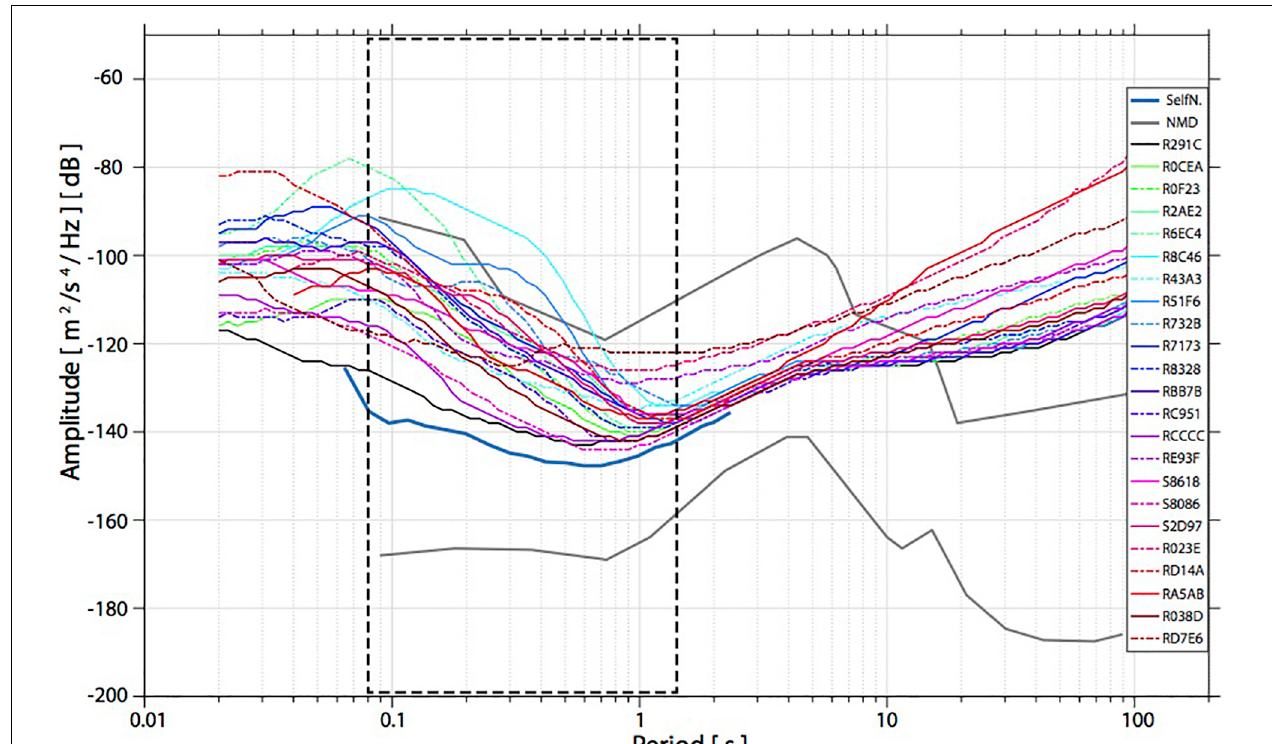
FIGURE 7 | Power spectral density probability density function’s median value for each NSSN station as a function of period. Thick gray lines are the high and low noise models (according to Peterson, 1993; McNamara and Buland, 2004). For comparison, we also plot the same curve from the test site in Switzerland (R291C), and the instrument self-noise as provided by the manufacturer. The dashed black line highlights the bandwidth of flat instrument response. The curves are constructed using hourly PSDs with 50% overlap during the period from June to December 2019.